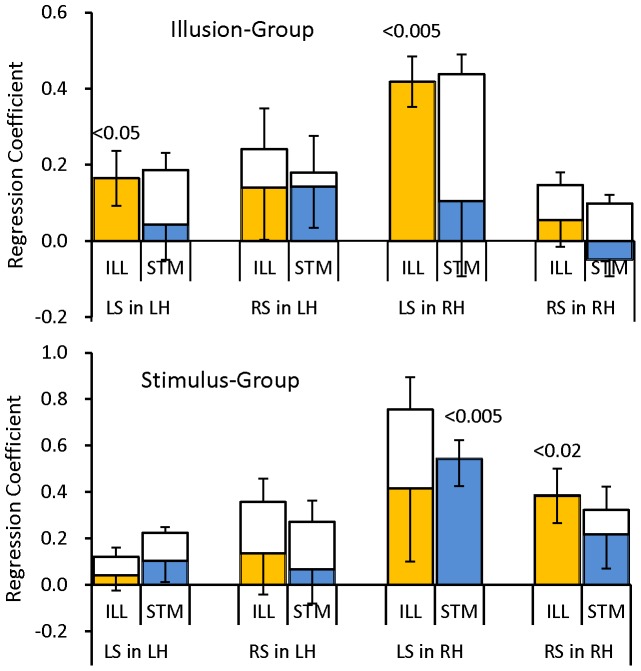
Mean values (color column) and mean of absolute values (white column above zero line) across subjects (n = 6) of ILL type and STM type regression coefficients (indicated below the column) in the response components of LS/RS in the LH/RH.Note the difference in the vertical scale between ILL and STS groups. SE bars are indicated in positive and negative directions for the absolute mean and the mean, respectively. P-values indicate the significance level above zero in the t-test.